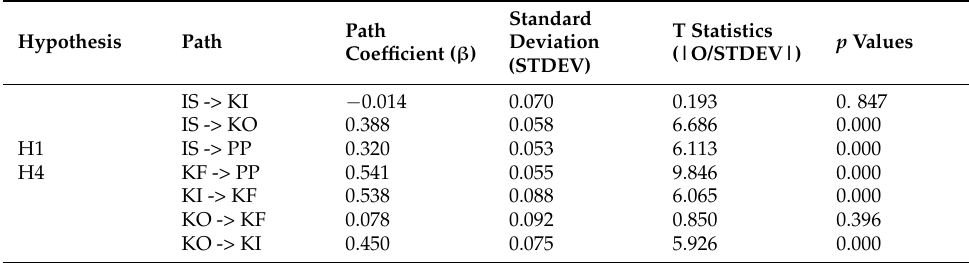
Table 7. Summary of path